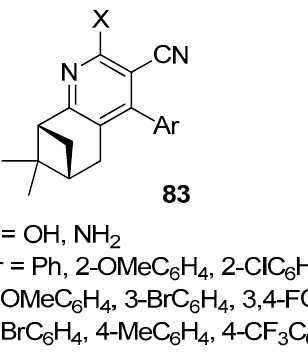
Figure 20. Representative pinene derivatives with pharmacological activity. Thiosemicarbazones, containing thiourea moiety, show significant biological—particularly anticancer—activities. Wang and co-workers [81] designed and synthesized a collection of nopinone- based thiosemicarbazone derivatives 87 as potent antineoplastic agents (Figure 20). Most of those thiosemicarbazones demonstrate considerable cytotoxic activity against three human cancer cell lines (MDA-MB-231, SMMC-7721, and Hela). Among thiosemicarbazone derivatives, the compound with